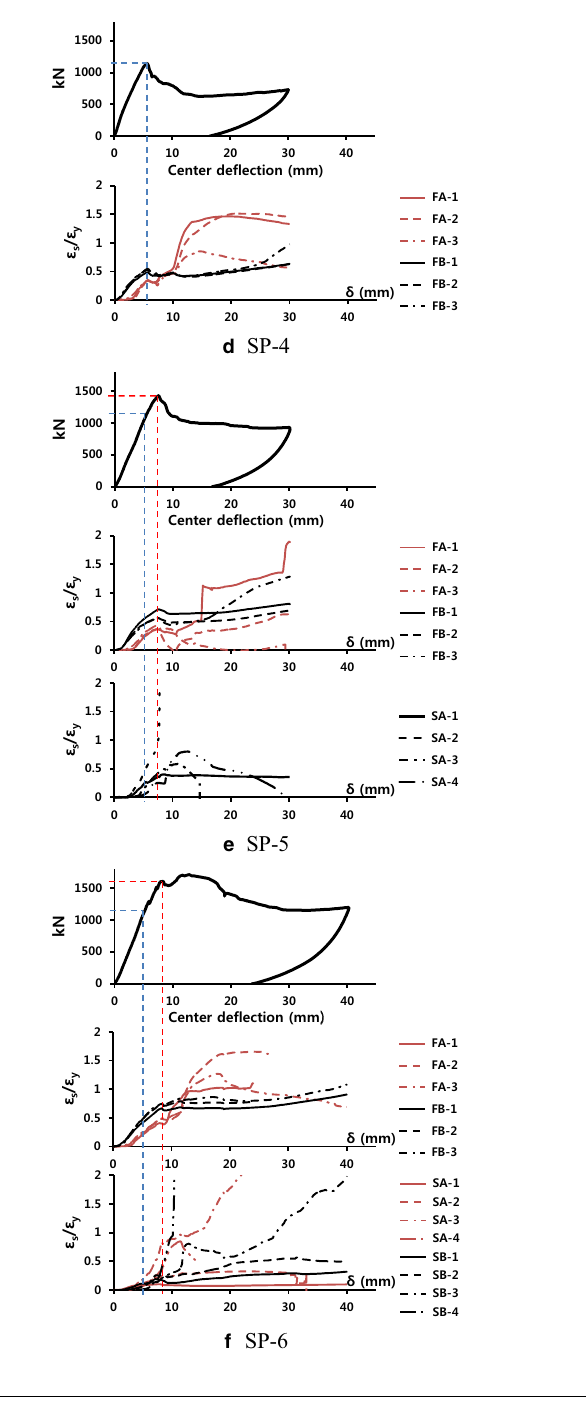
the accuracy of the estimation formula by the codes are shown. Figure 9a, which is based on ACI 318 (ACI 2014), shows a relatively accurate strength estimation when the flexural reinforcement ratio and amount of